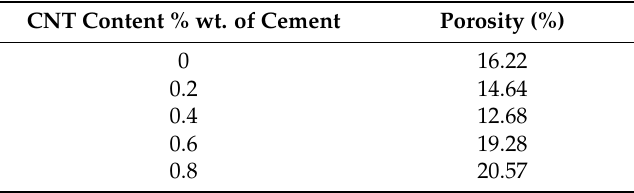
Table 2. Porosity values for nano-modified mortars.